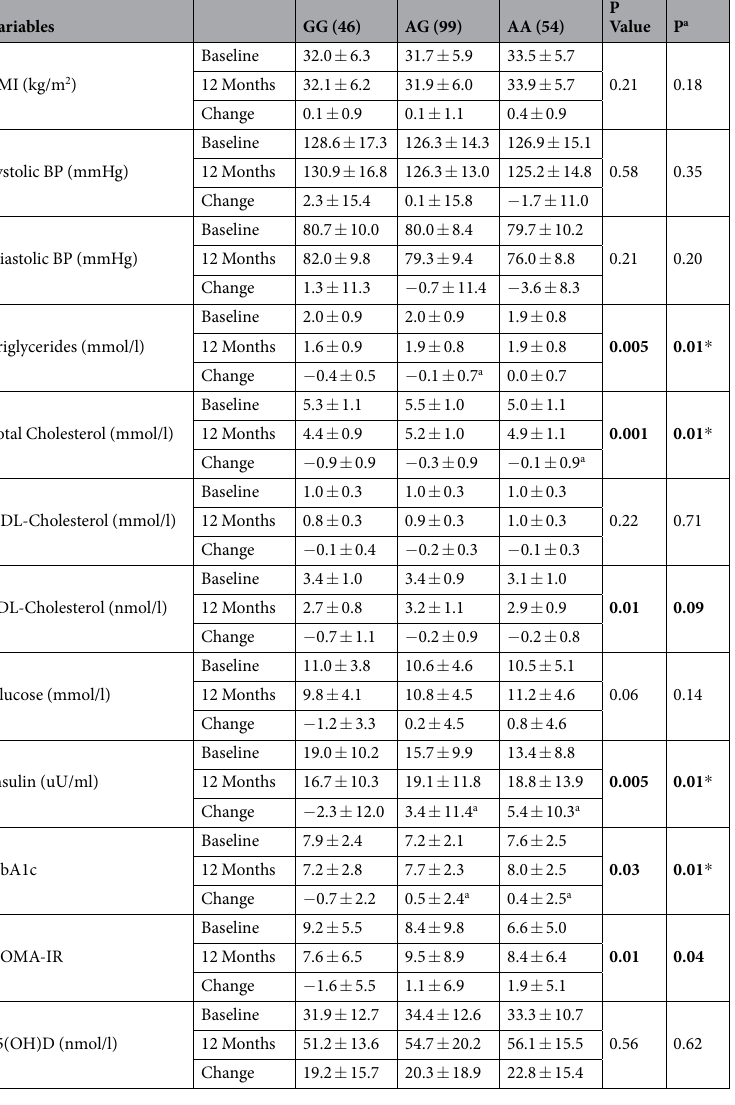
Table 4. Comparisons of the variables among the Taq-I genotypic before and after 12 months of vitamin D supplementation. Note: Change = Follow up − Baseline; p values presented are for the changes in different variables after vitamin D supplementation according to Taq-I genotypes; P a indicates p values after adjusting age, gender, BMI and baseline 25(OH)D levels; Superscript “a” indicates significantly different from GG group after post hoc analysis; “ * ” indicates p < 0.05 after Bonferroni